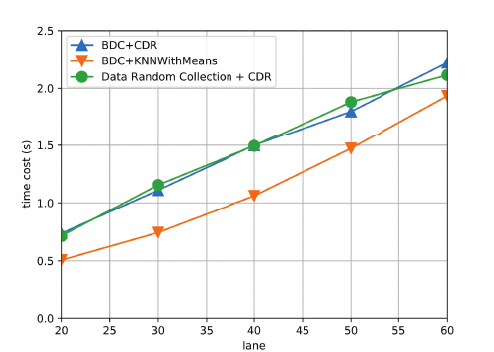
Figure 12. The time cost of three algorithms under different numbers of covered road